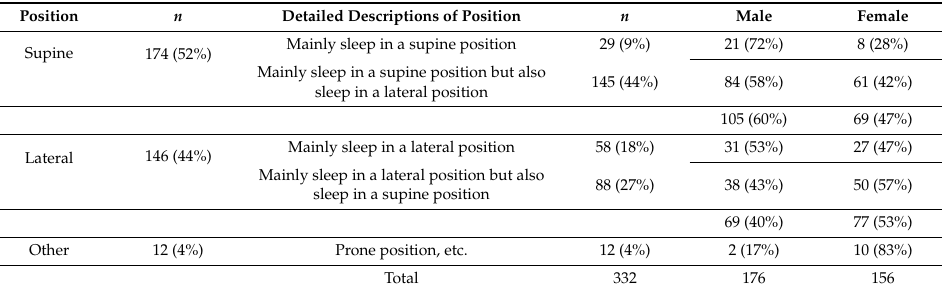
Table 4. Descriptive statistics of sleeping